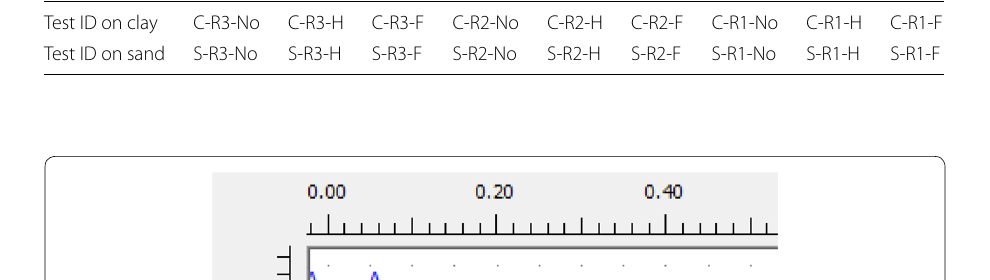
Table 2 The test program conducted on clay and sand soil bed Test ID on clay